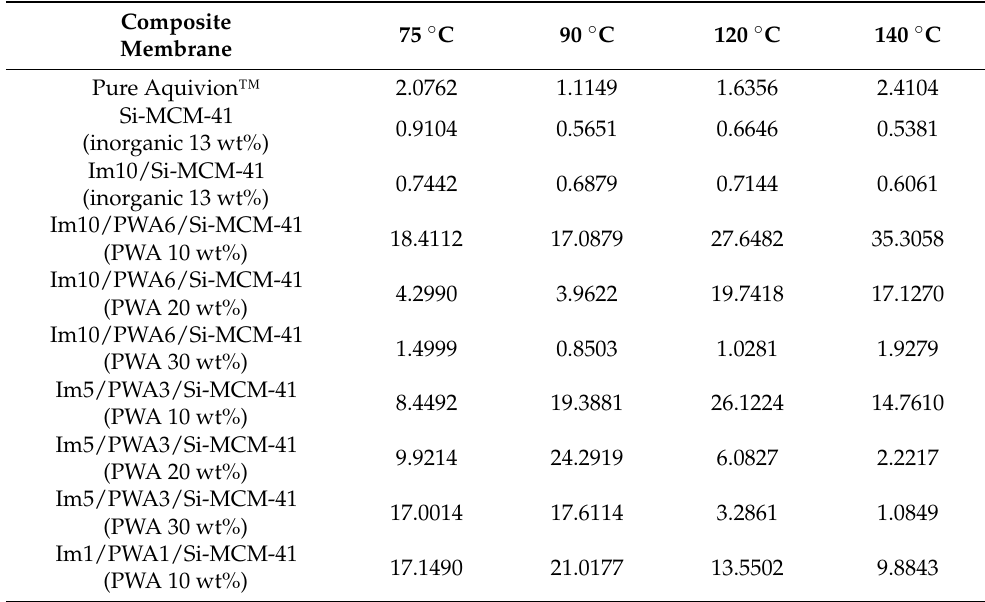
Table 3. Proton conductivity of Im(x)/PWA(y)/Si-MCM-41 and Aquivion™ composite mem- branes